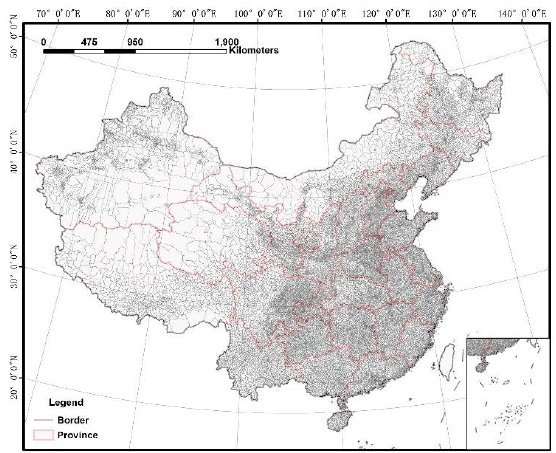
Figure 1. Study area.